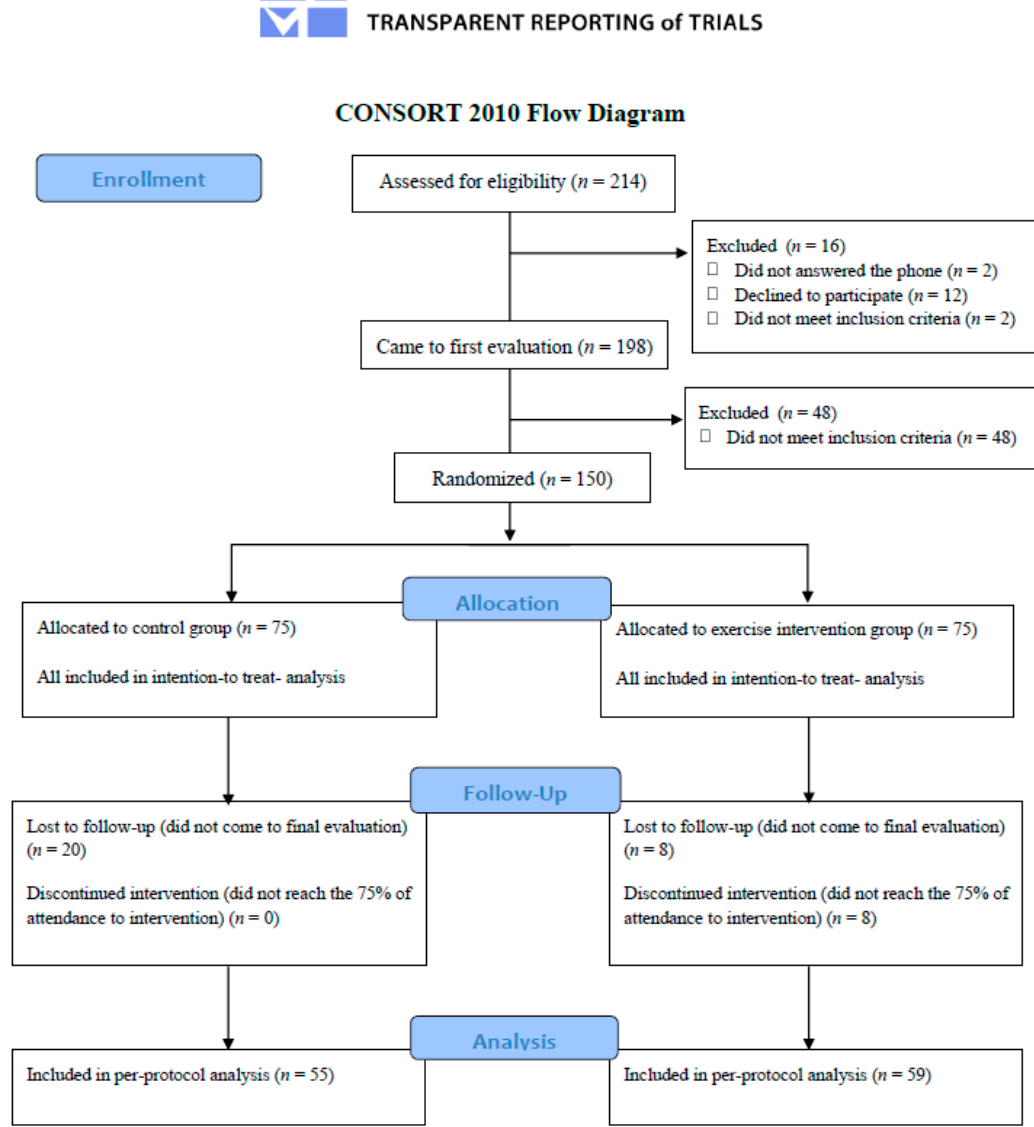
Figure 1. Flow chart of the study participants.